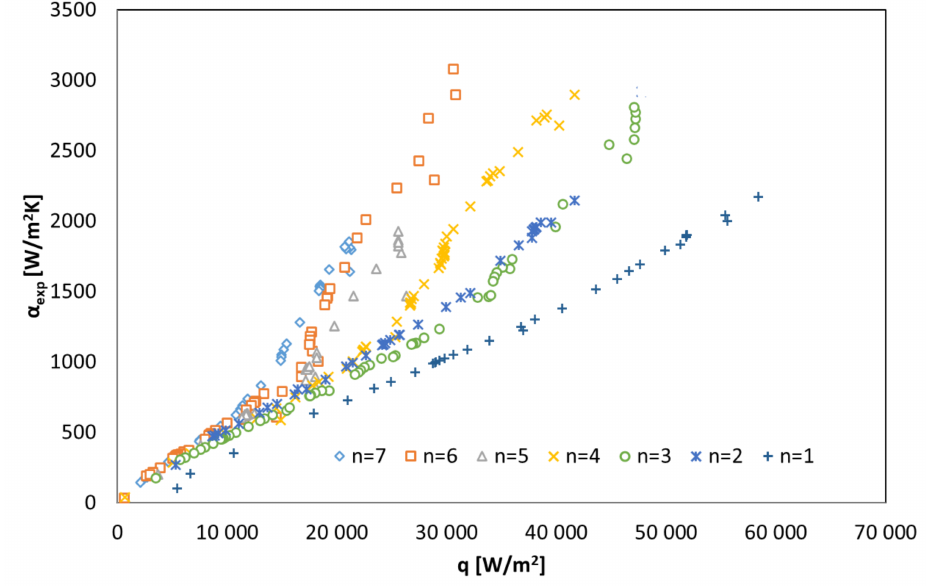
Figure 7. Collective experimental research data on the condensation of the HFE 7100 refrigerant in a shell-and-tube exchanger, concerning the dependence of the heat transfer coefficient on the heat flux density; n—number of active pipe minichannels.